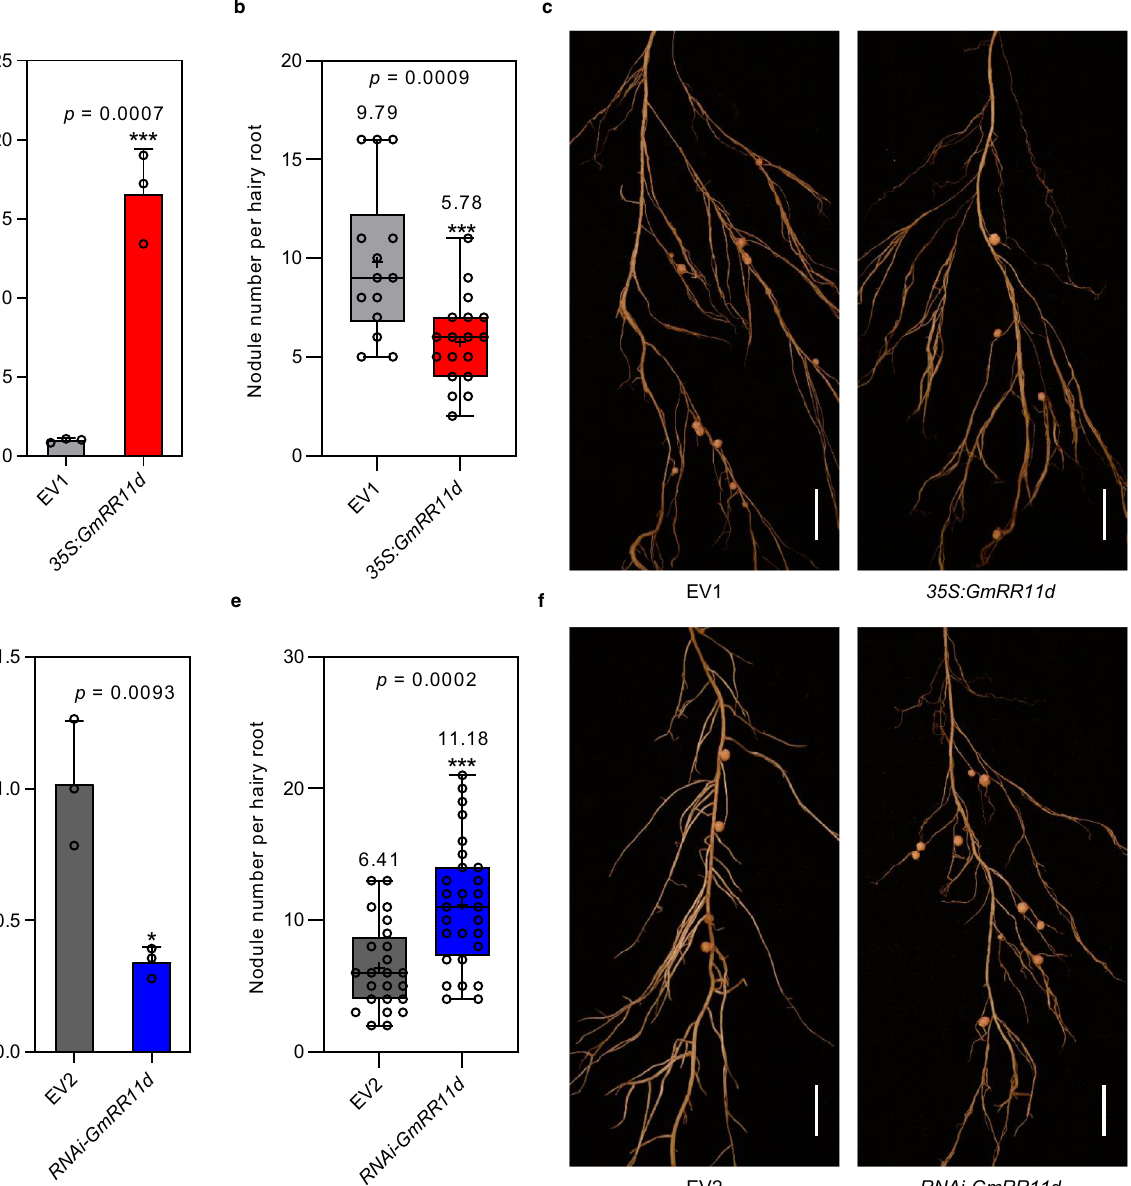
Fig. 4 | Alterations of GmRR11d expression affect nodulation. a – c Overexpression of GmRR11d reduces nodule number. a qRT-PCR analysis of transgenic hairy roots expressing 35S : GmRR11d . The expression levels were nor- malized against the geometric mean of soybean GmELF1b . Data are presented as means±SD from three biological replicates. Asterisks indicate signi fi cant differ- ences relative to the EV1 control. Two-sided Student ’ s t -test *** p 0.001. b , c Quanti fi cation and representative images of nodule number per hairy root expressingEV1and 35S : GmRR11d .Dataarepresentedasmeans±SD(14hairyroots in EV1 and 18 hairy roots in 35S : GmRR11d ). Three independent experiments were repeated with similar results. Asterisks indicate signi fi cant differences relative to the EV1 control. Two-sided Student ’ s t -test, *** p <0.001. Scale bars=1cm. d – f Knockdown of GmRR11d increases nodule number. d qRT-PCR analysis of transgenic hairy roots expressing RNAi-GmRR11d . The expression levels were